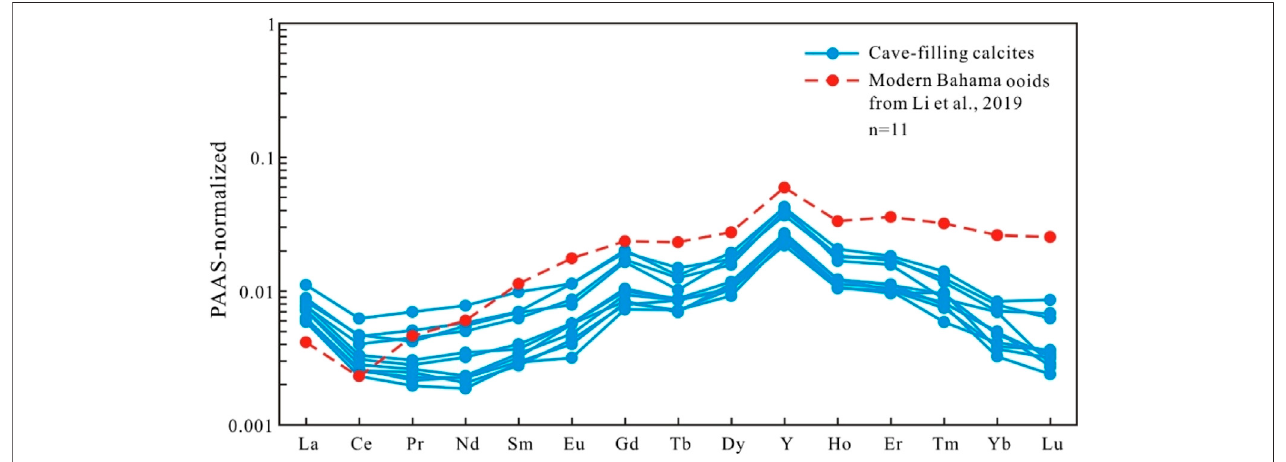
FIGURE 6 | PAAS-normalized REEY patterns of CFC and modern Bahama ooids (from Li et al., 2019).